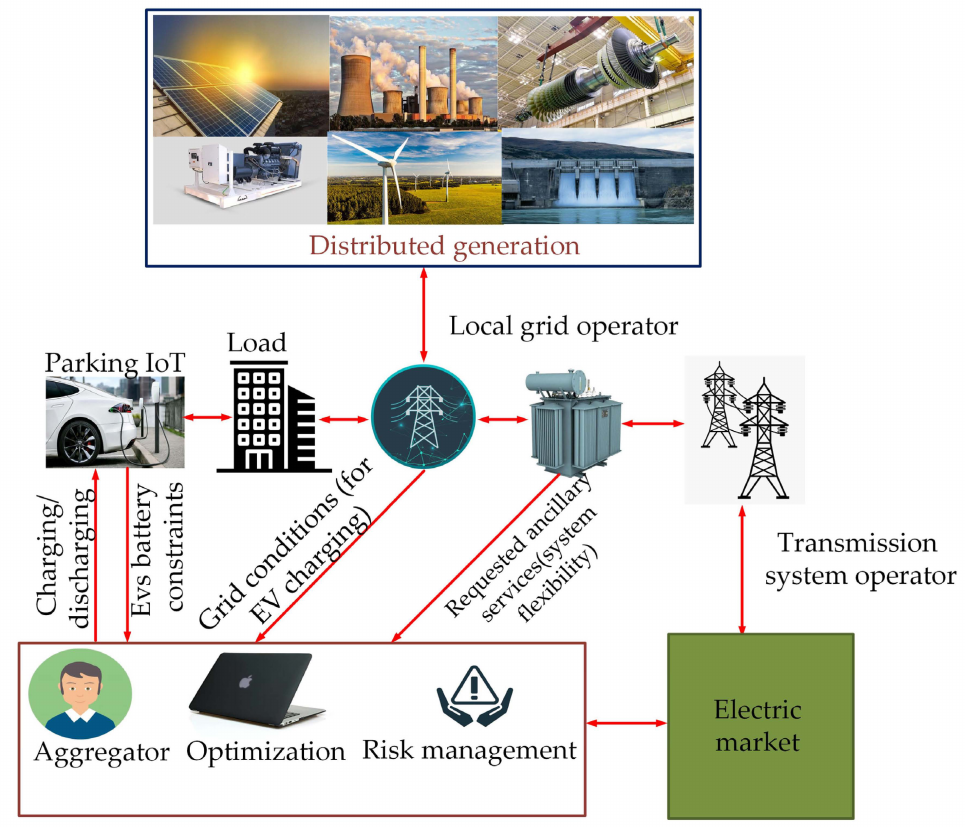
Figure 2. Schematic diagram showing the smart charging of V2G in power